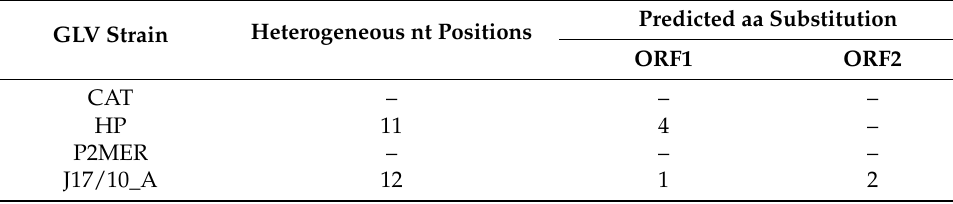
Table 3. List of heterozygous nucleotide position in GLV genomes. Predicted aa Substitution GLV Strain Heterogeneous nt Positions ORF1 ORF2 CAT – – – HP 11 4